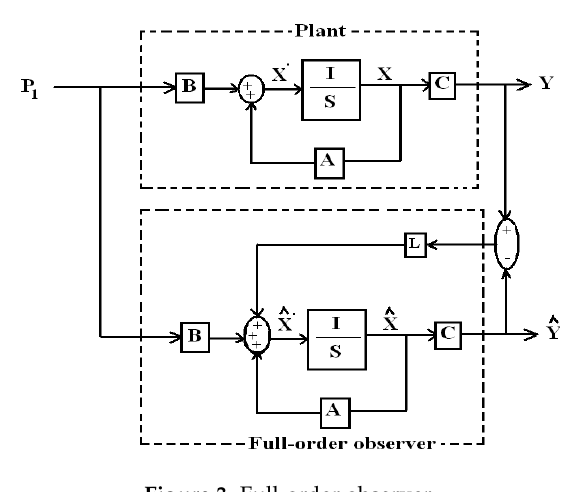
Figure 3. Full-order